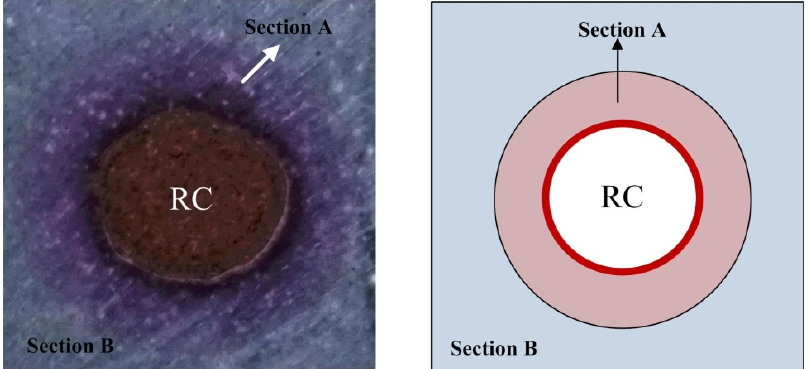
Figure 1. The internal curing range area of prewetting spherical lightweight aggregate in cement slurry with a low water-binder ratio.